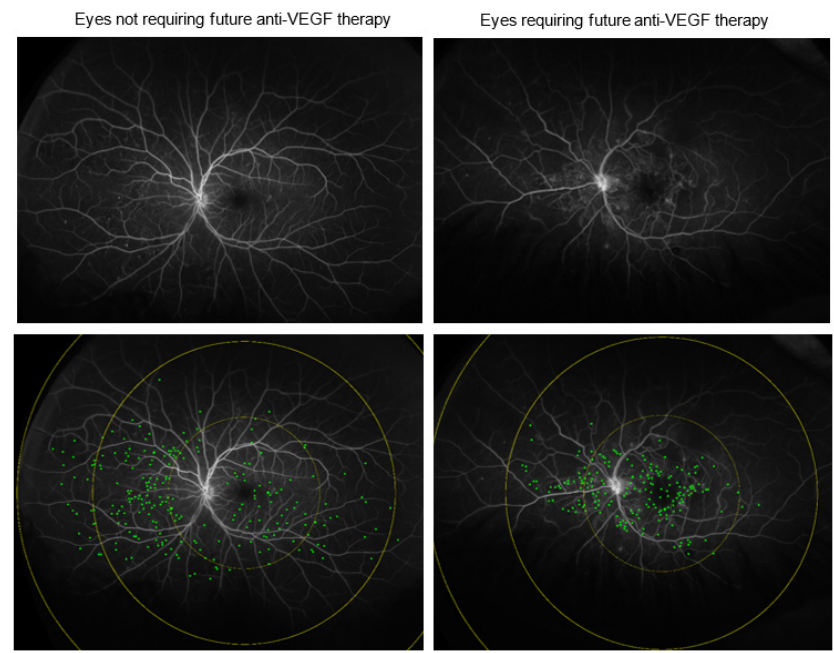
Figure 3 . MA count in eyes requiring future anti-VEGF therapy. Total MA count and posterior pole MA count on UWFA were significantly higher in eyes requiring future anti-VEGF therapy compared to eyes not requiring future injections.